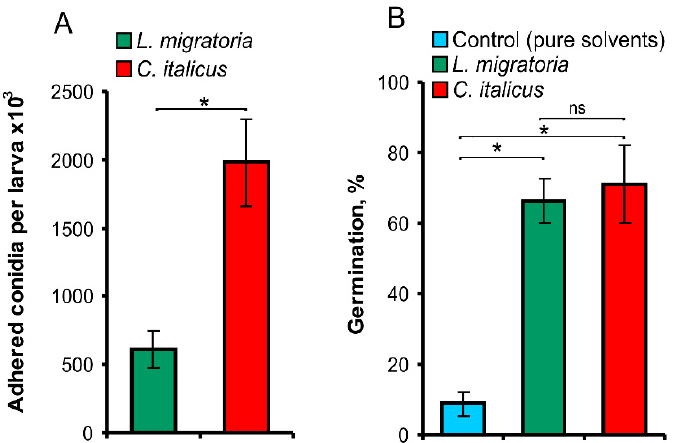
Figure 5. The number of M. robertsii conidia adhering to L. migratoria and C. italicus cuticles after dipping in a suspension containing 10 8 conidia/mL ( A ), and conidia germination on the L. migratoria and C. italicus epicuticular extracts applied to the agarose surface ( B ). * Significant differences between the species ( t -test, p < 0.003); ns: nonsignificant differences.